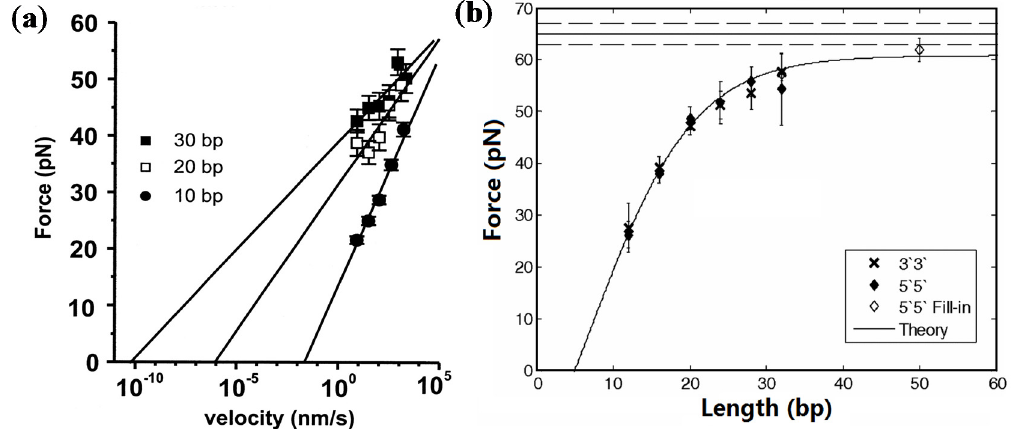
Figure 2. ( a ) Velocity dependence of the rupture force. Data showing the most probable rupture force as a function of stretching velocity for the short dsDNA of 30 bp, 20 bp, and 10 bp. The rupture force scales linearly with the logarithm of velocity. Adapted from [48]. Copyright (1999) National Academy of Sciences, USA; ( b ) Dependence of the rupture force on the length of dsDNA. The central horizontal line is the critical force of the overstretching transition measured in the λ -phage DNA. The upper and lower lines correspond to 10% and 90% of overstretching transition, respectively. Adapted from [39]. Reprinted with permission. Copyright (2005) American Physical